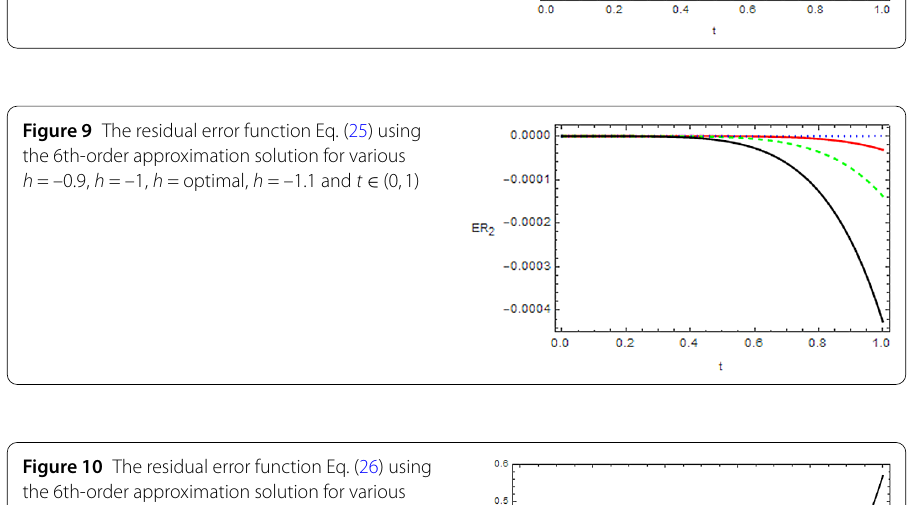
Figure 10 The residual error function Eq. (26) using the 6th-order approximation solution for various h = –0.9, h = –1, h = optimal, h = –1.1 and t ∈